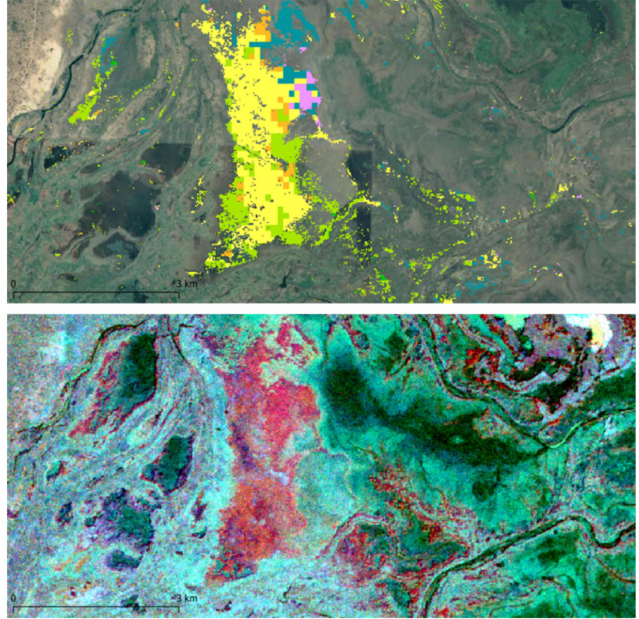
Figure 15. Detail area ( c ) in Figure 10. Top: pixels corresponding to cluster 6, colored according to the underlying CORINE class; background from Google Earth TM imagery. Bottom: same area, extracted from the RGB change image in Figure 12.